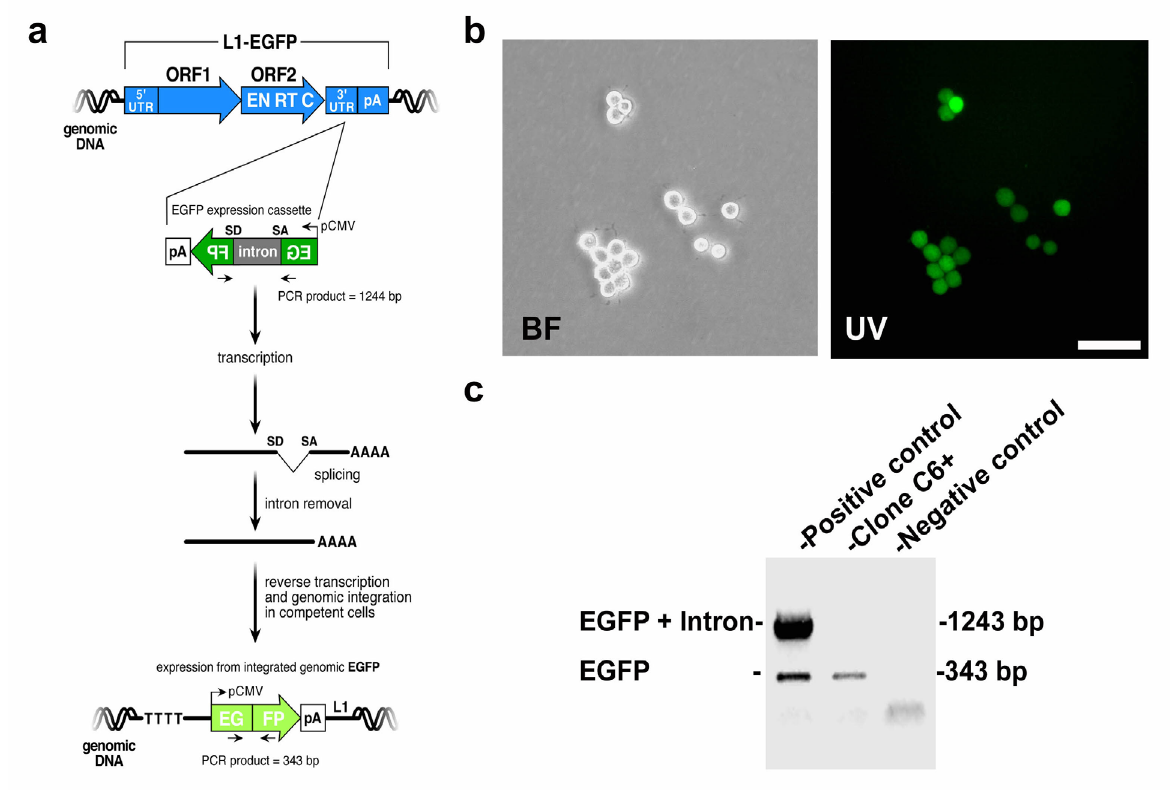
) contains a 5’ untranslated Figure 1 - Isolation of clone C6+ by L1-EGFP retrotransposition. a , The retrotransposition-competent human L1 (L1 RP region (UTR) that harbors an internal promoter, two open reading frames (ORF1 and ORF2; not drawn to scale), and a 3’ UTR that ends in a poly (A) tail. ORF2 contains an endonuclease (EN) and reverse transcriptase (RT) domains, as well as a cystiyne-rich 3’ end (C). The EGFP retrotransposition indicator cassette consists of a backward copy of the EGFP gene whose expression is controlled by the human cytomegalovirus major immediate early promoter (pCMV) and the herpes simplex virus thymidine kinase polyadenylation sequence (pA). This arrangement ensures that EGFP expression will only become activated upon L1 retrotransposition . The black arrows indicate PCR primers flanking the intron present in the EGFP gene. b , Bright field and UV images are shown of clone C6+ cells containing an L1 retrotransposition event derived from a single cell. Bar = 20 mm. c , PCR analysis of genomic DNA isolated from the clone C6+. PCR was conducted using the primers shown in panel a . The 1243-bp PCR product corresponds to the original L1 vector harboring the intron-containing EGFP indicator cassette. The 343-bp PCR product, diagnostic for the loss of the intron, is indicative of a retrotransposition event. Sequencing of the 343-bp PCR product confirmed the precise splicing of the intron (data not